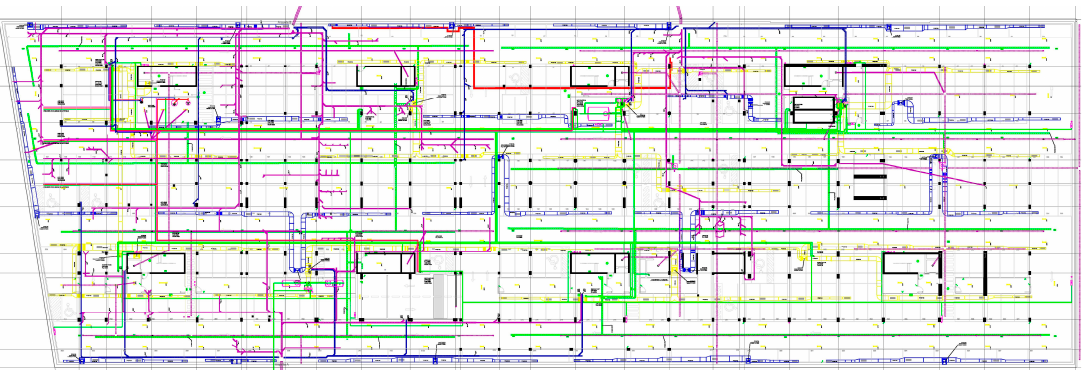
Figure 2. MEP planimetry from the base execution project (PEB).